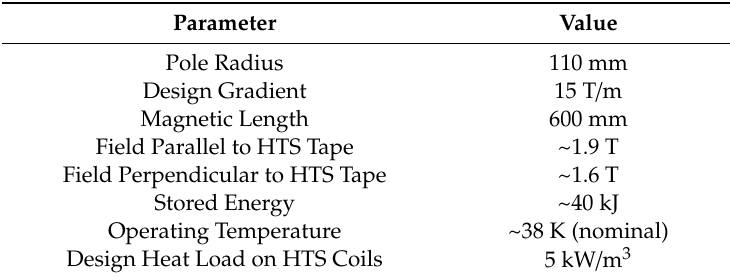
Table 3. The primary parameters of the HTS quadrupole magnet for